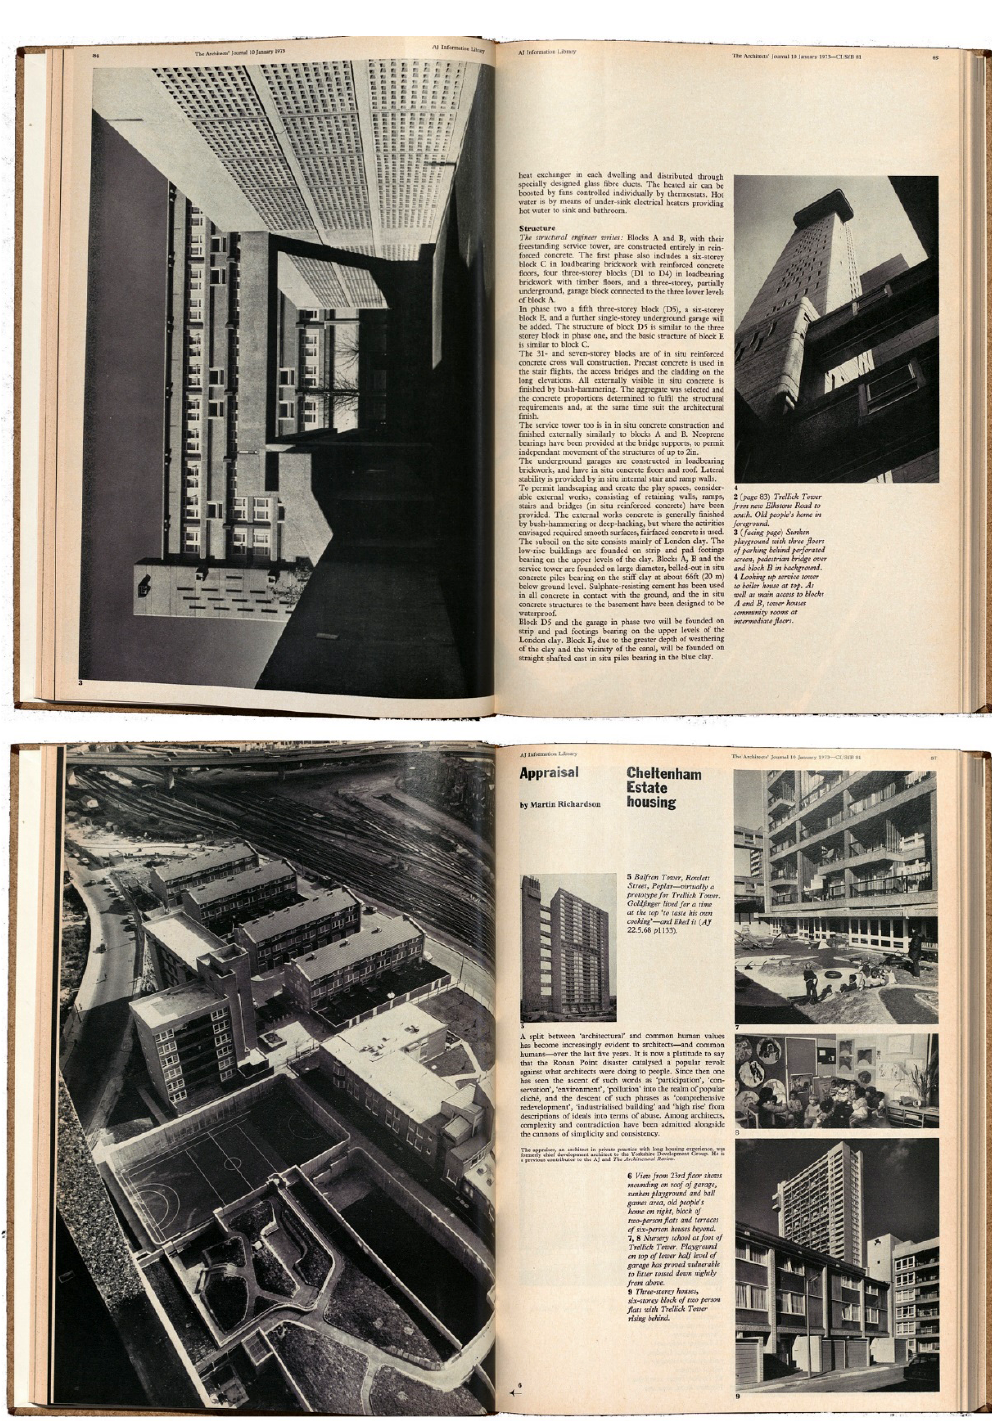
Figure 12. Richardson M. (1973). Cheltenham Estate housing, Architects’ Journal , 157